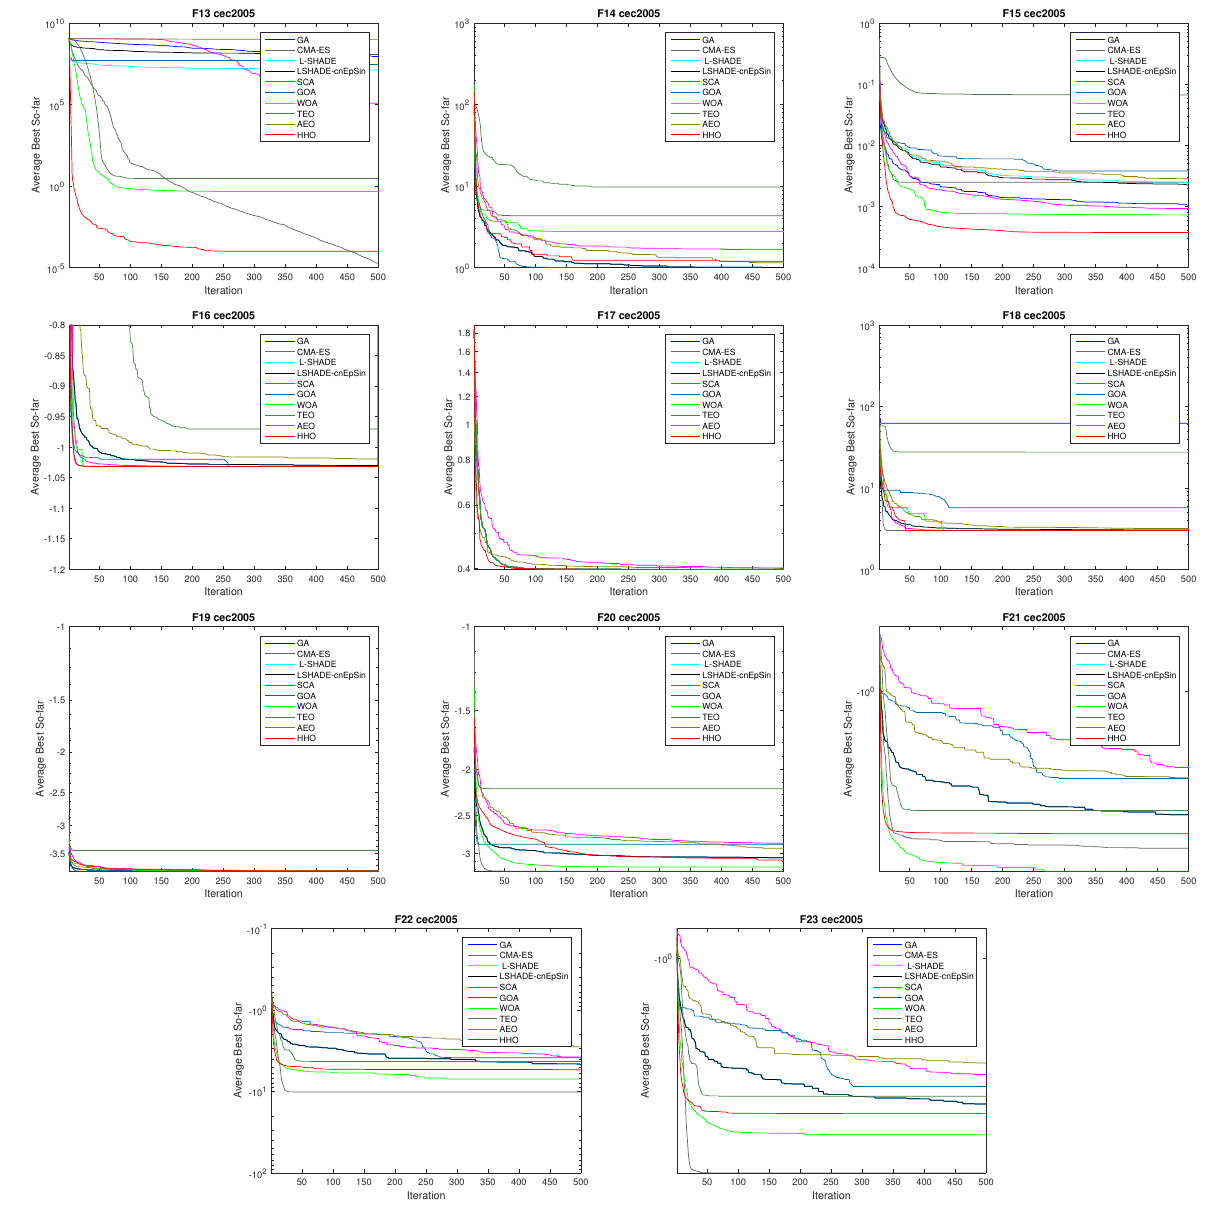
Figure 3. Convergence curve for HHO against other competitors from F13–F23